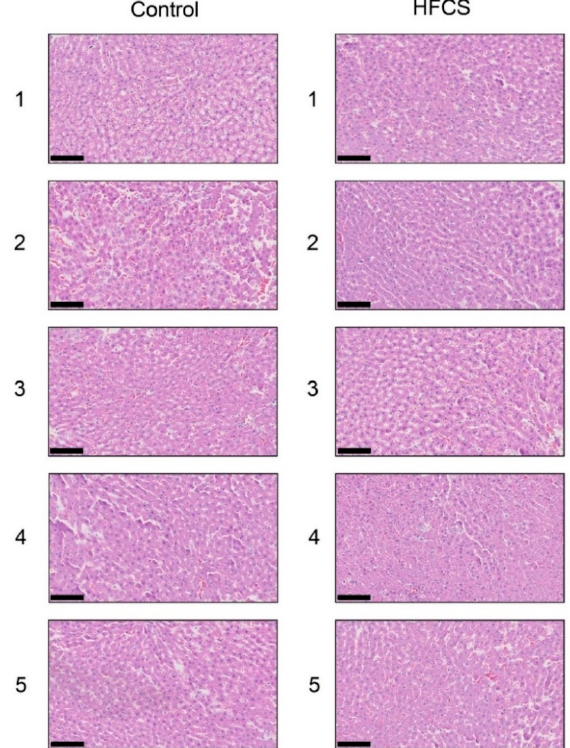
Figure 1. Histological analysis of the liver with hematoxylin and eosin staining. Control; control group, HFCS; HFCS group. The numbers 1–5 indicate each rat in the control group ( n = 5) or HFCS group ( n = 5). The scale bar represents 100 μ m.